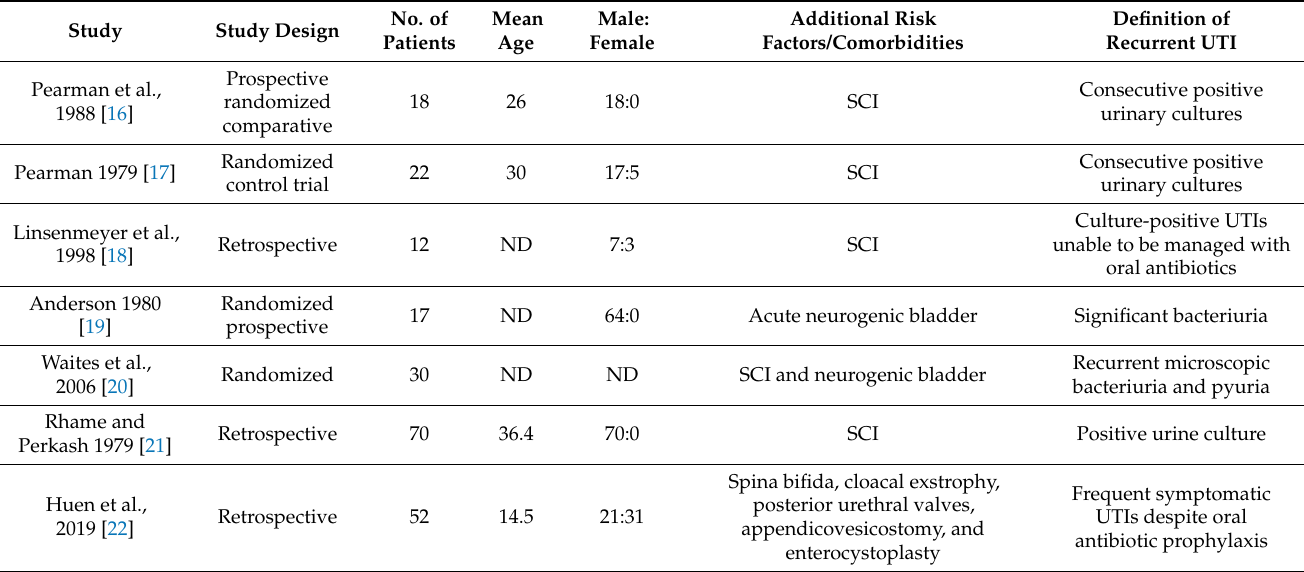
Table 2. Characteristics of studies on the use of an intravesical aminoglycoside in combination with polymyxin for UTI.